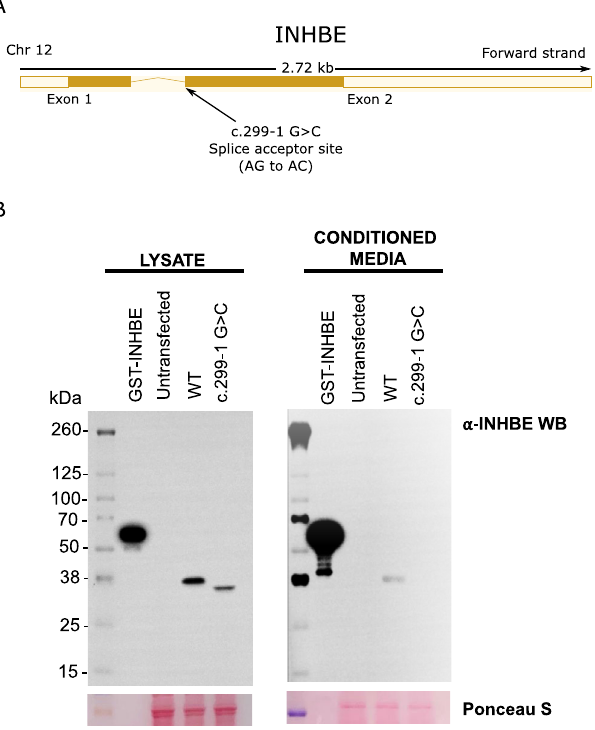
Fig. 6 | In vitro expression of the INHBE c.299-1G>C splice acceptor variant. A showsagenemodelfor INHBE withthepredictedlossoffunctionspliceacceptor variant(c.299-1G>C)highlighted. B showsaWesternblotanalysisforINHBEprotein in cell lysates and conditioned media from CHO cells transfected with wild-type INHBE or the INHBE c.299-1G>C splice acceptor variant. Full length GST-tagged recombinant INHBE protein (100ng) was used as a positive control and staining with Ponceau S was used to compare sample loading across samples. The image is representative of one of three technical replicates. Each replicate yielded similar results. Chr chromosome, CHO Chinese hamster ovary, GST Glutathione